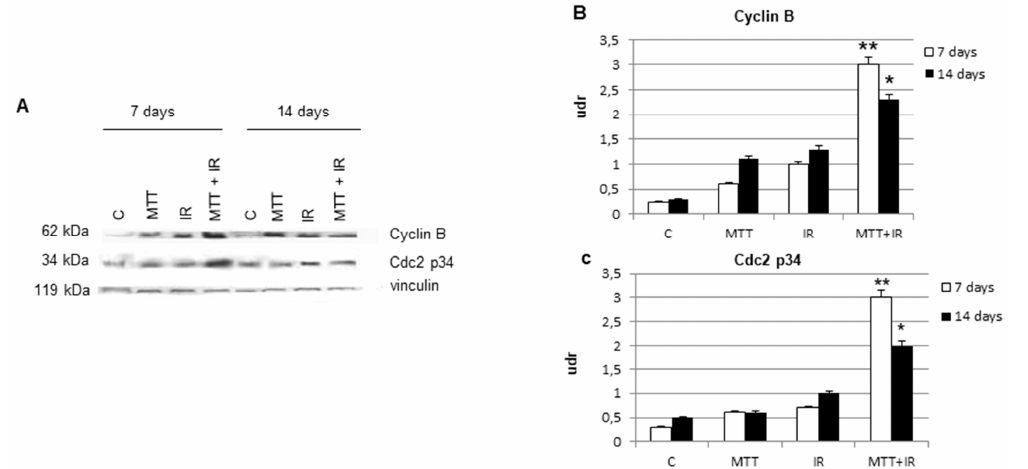
Figure 5. Cell cycle molecules. Western blot analysis of cyclin B and the Cdc2 p34 catalytic subunit in tumor samples from treated and untreated mice at 7 and 14 days ( A ). Bar graphs of the cyclin B and Cdc2 p34 expression levels. Cyclin B and Cdc2 p34 are significantly increased at 7 days in the MTT/IR treated samples than in other treatments ( B , C ), and their levels appear lower at 14 days, according to cell cycle FACS data ( B , C ). Densitometry readings/intensity ratio in triplicate of each band of Western